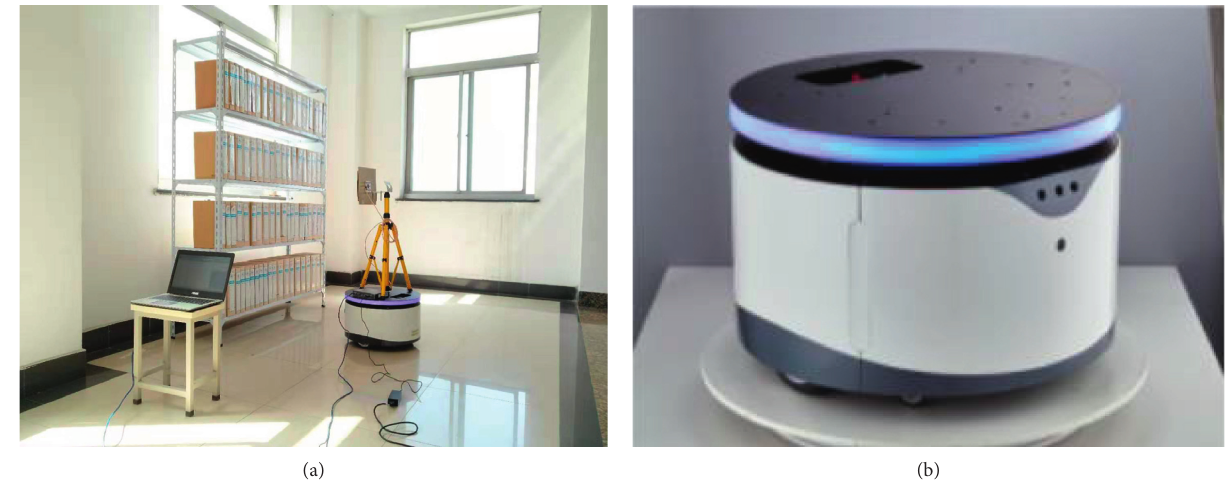
Figure 3: Test environment, (a) experimental test platform, and (b) water droplet robot.